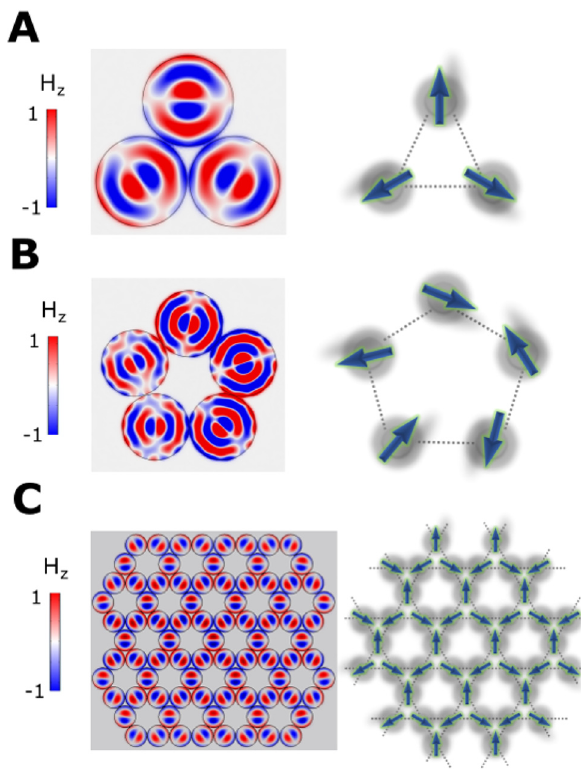
Figure 4: Geometric frustration in the XY Hamiltonian with AF couplings. (A) Lasing in the TE 13 and (B) TE 14 resonant modes of nanodisk lasers arranged in arrays of three and fi ve elements, respectively. In these scenarios, the structure emulates an AF exchange interaction among nearest-neighbor elements, where the ground state is expected to show geometric frustration. The FEM simulations indeed con fi rm such behavior with 120 ° and 144 ° suc- cessive rotation between consecutive elements in (A) and (B), respectively.(C)KagomelatticeofnanodisklaserswithAFexchange interactions. A frustrated lasing supermode is observed in simula- tions, as expected from the ground state shown in the